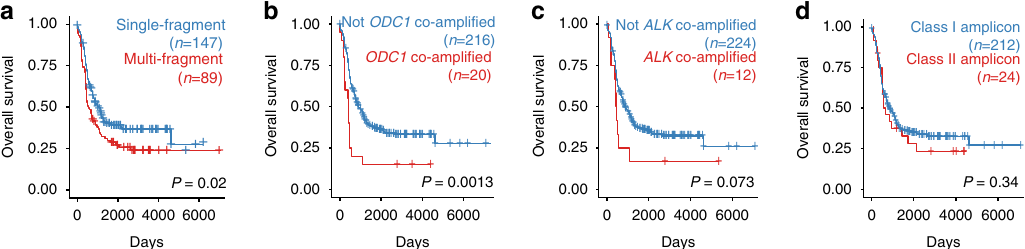
Fig. 6 Class II amplicons clinically phenocopy class I amplicons. Kaplan Meier survival analysis of patients with MYCN -ampli fi ed neuroblastoma, comparing single-fragment vs. multi-fragment ampli fi cation ( a ), co-ampli fi cation of ODC1 vs. no co-ampli fi cation ( b ), co-ampli fi cation of ALK vs. no co- ampli fi cation ( c ), and class I amplicons vs. class II amplicons ( d ; N = 236 MYCN -ampli fi ed neuroblastomas; P value based on two-sided log-rank test). Source data are provided as a Source Data fi le.